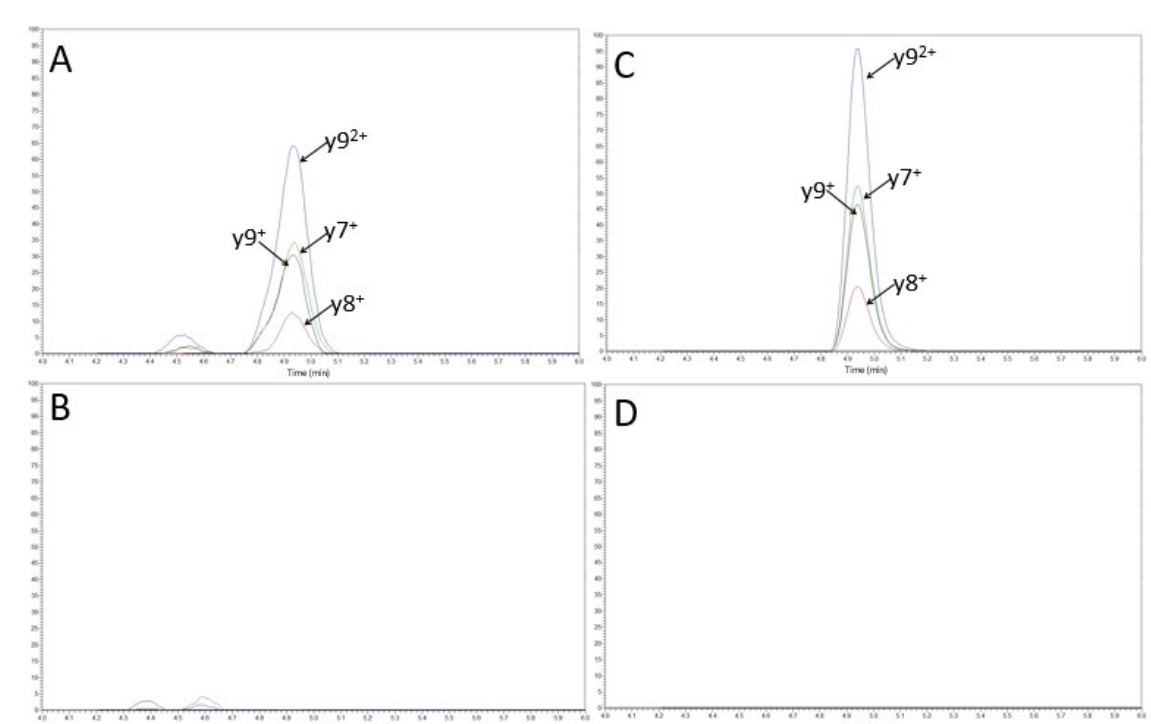
Figure 5. Chromatograms of a standard G1 (1 μg/mL of PBZ ( A ) and 10 μg/mL of SIL-PBZ-like ( C )) and a double blank sample ( B , D ).